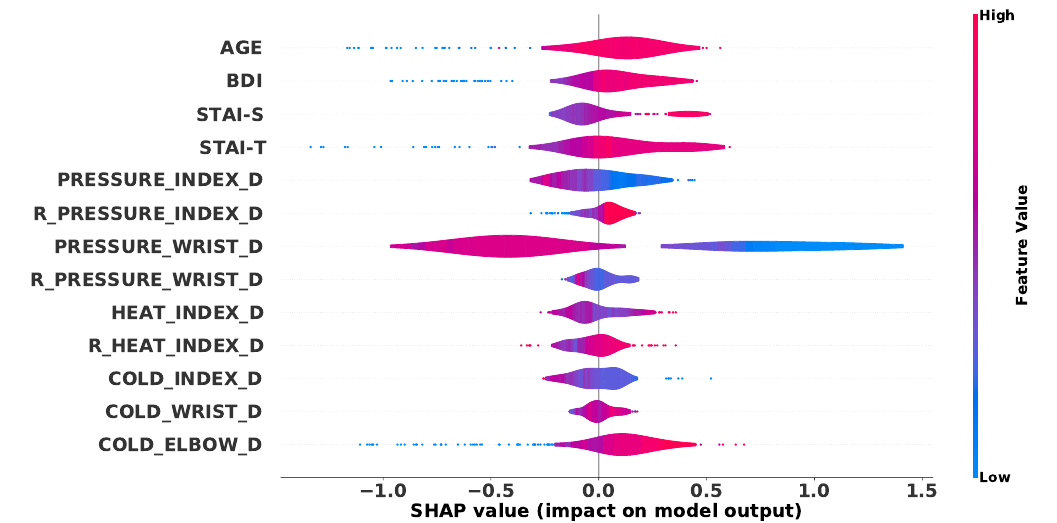
Figure 7. Summary explanation for the best extra trees classifier (ETC). Each dot represents one of the samples contained in the independent test. On the horizontal axis, the values indicate how much each feature (on the vertical axis) contributes for an HC or CP classification with negative and positive values, respectively. The color represents the feature value. The prefix “R_” among the quantitative sensory test (QST) variables indicates that they correspond to the ratio between pain ratings and stimulus intensity.